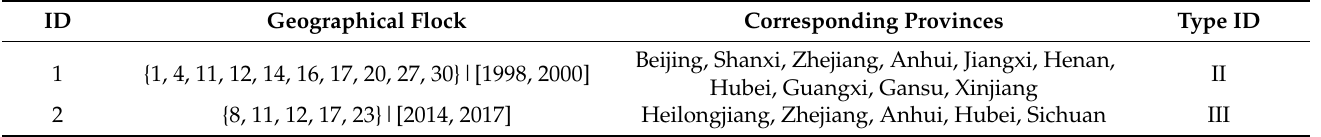
Table 4. The discovered geographical flock patterns based on the criterion of the extreme number- duration values on the province